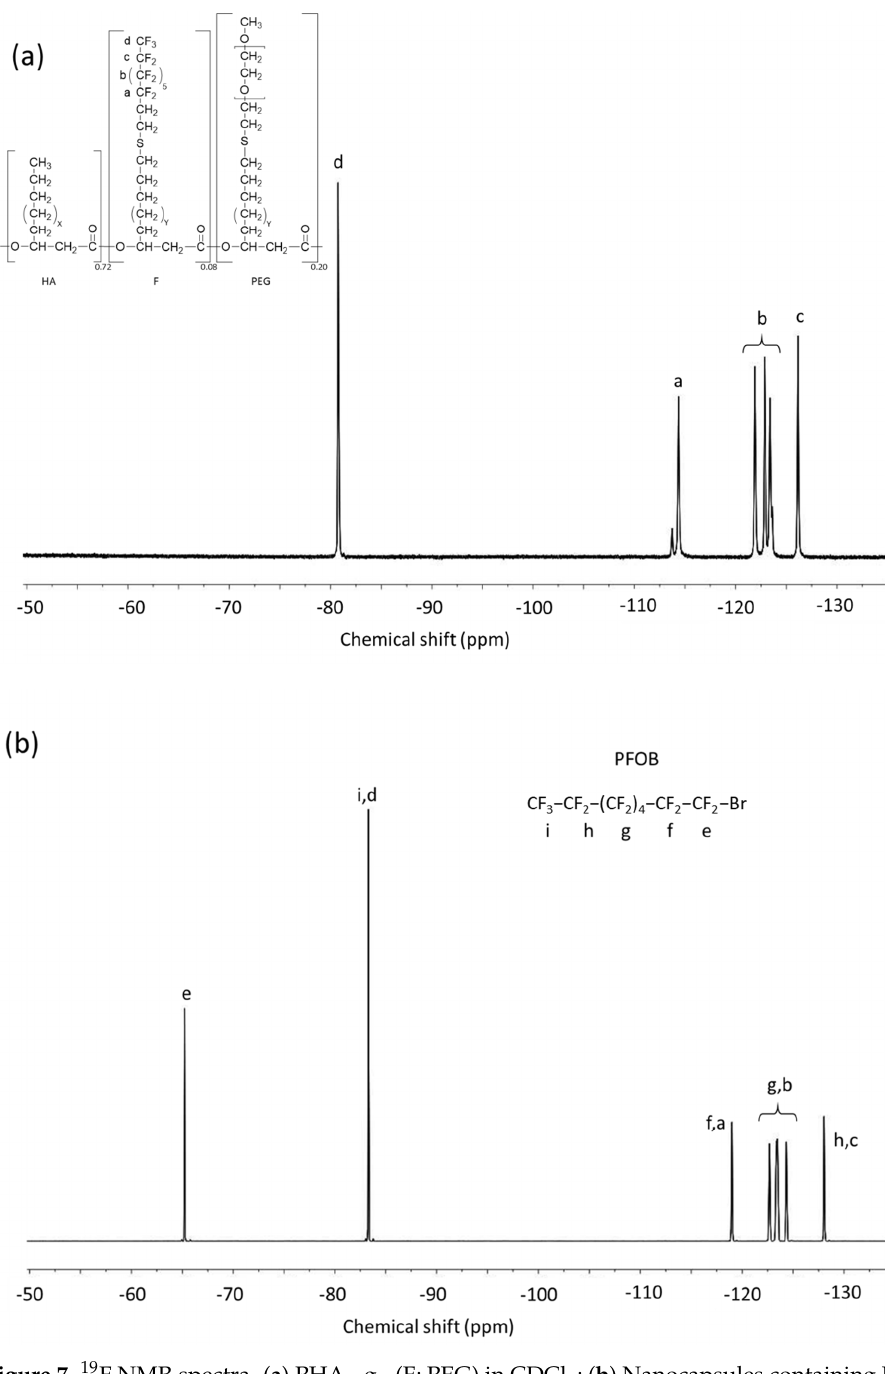
Figure 7. 19 F NMR spectra. ( a ) PHA−g−(F; PEG) in CDCl 3 ; ( b ) Nanocapsules containing PFOB in H 2 O-D 2 O (9:1).